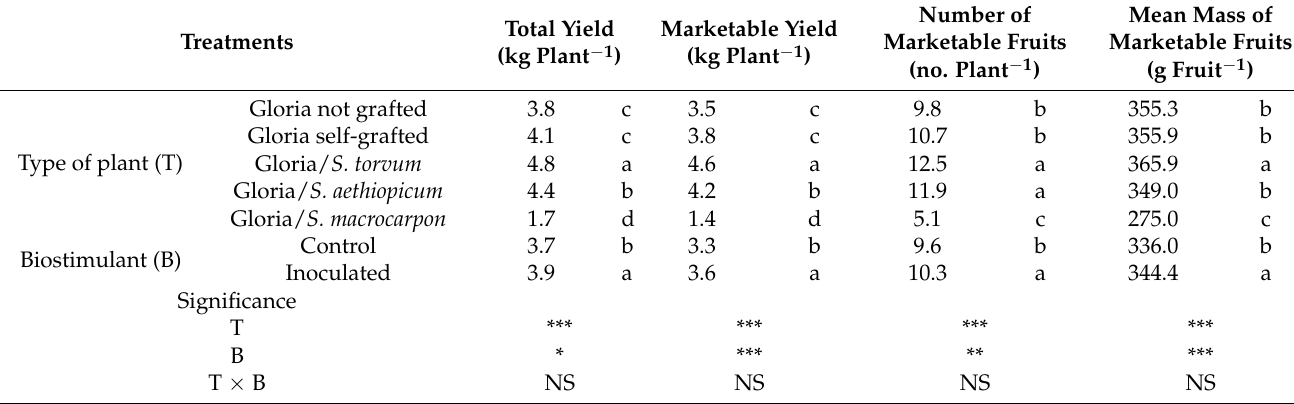
Table 1. Influences of the type of plant and biostimulant application on the total yield, marketable yield, number of marketable fruits and mean mass of marketable fruits of eggplant.